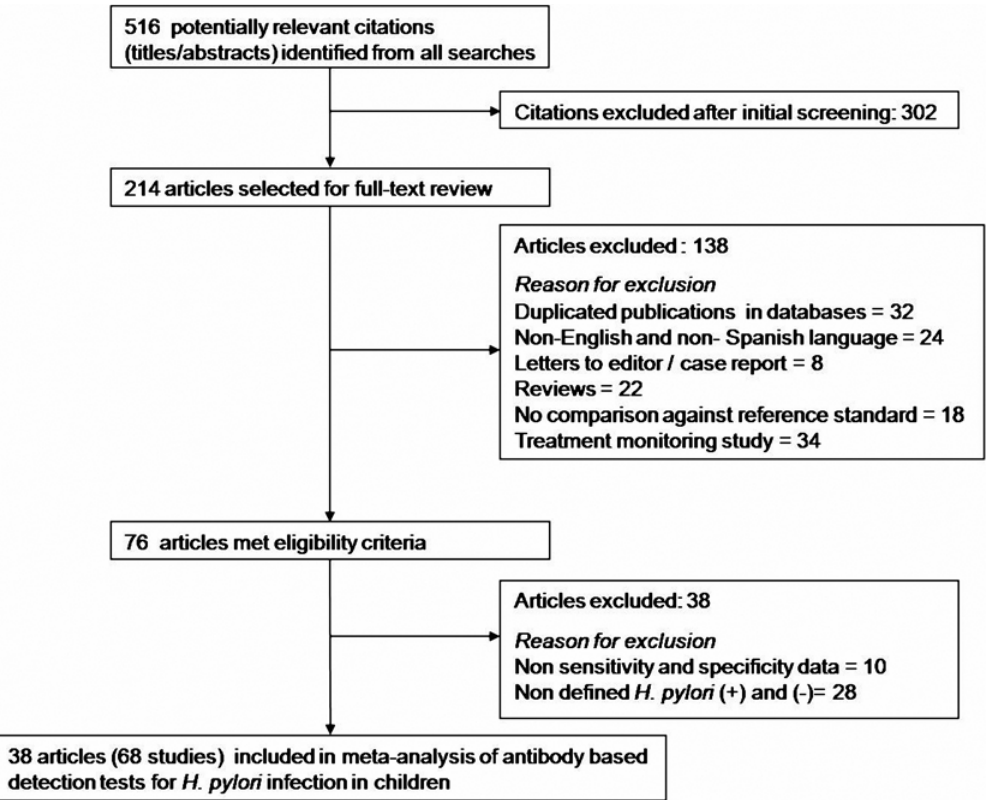
Figure 1. Study selection process and reasons for exclusion.